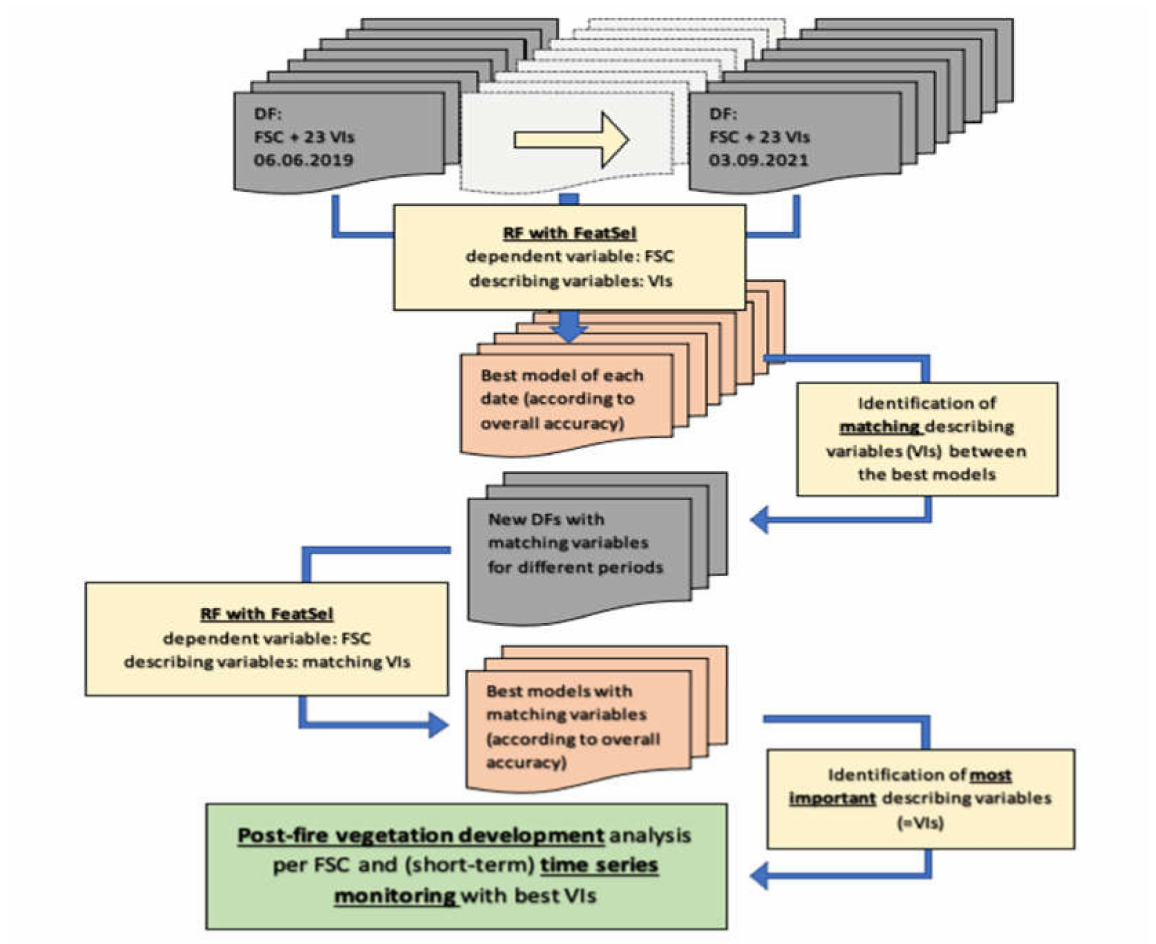
Figure 3. Identification of vegetation indices for post-fire vegetation development analysis per fire severity class and time series monitoring in the temperate